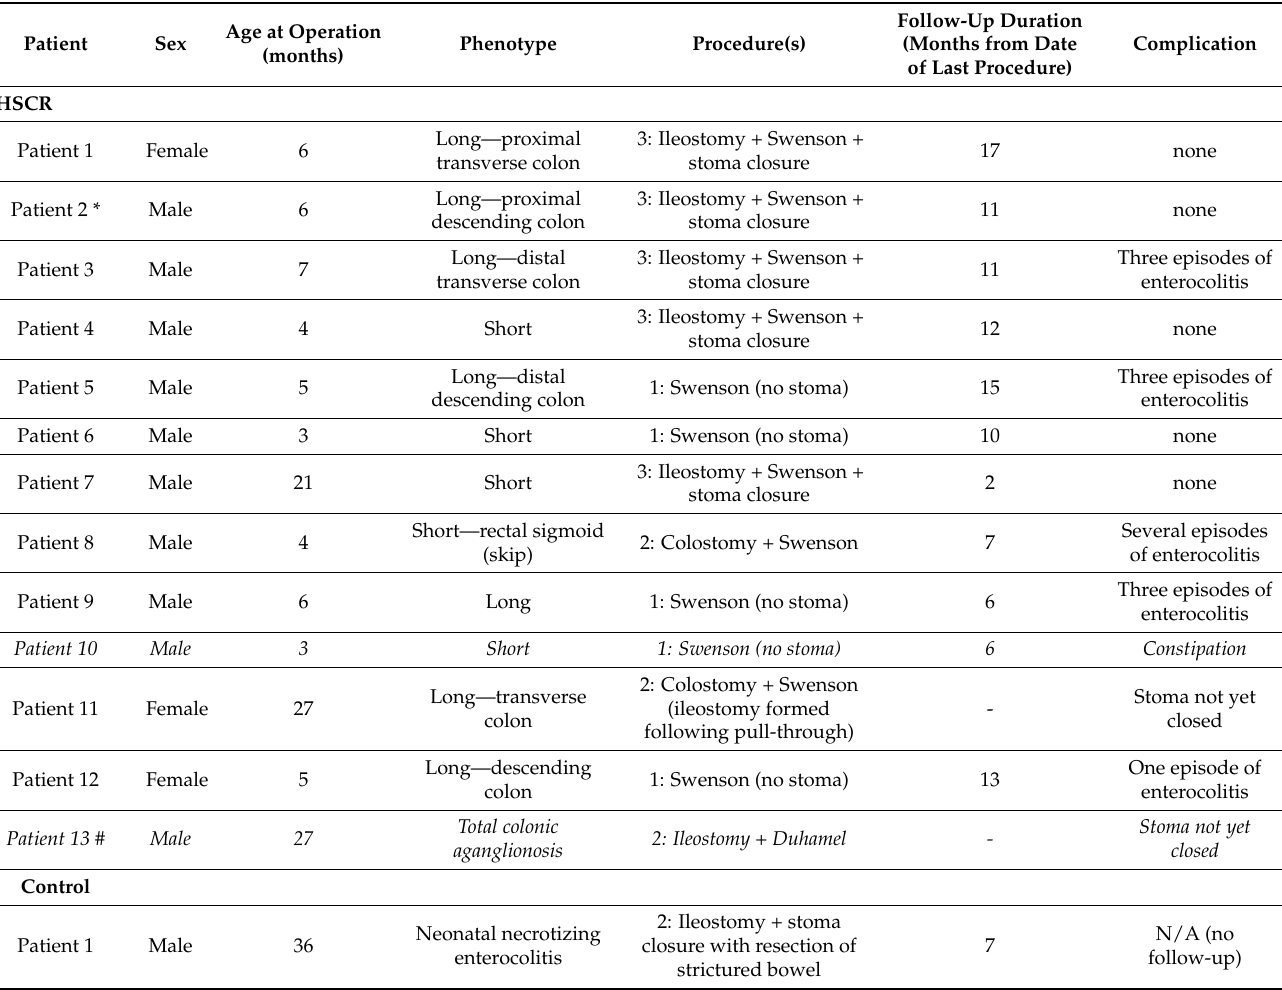
Table 1. Patient demographics and severity of